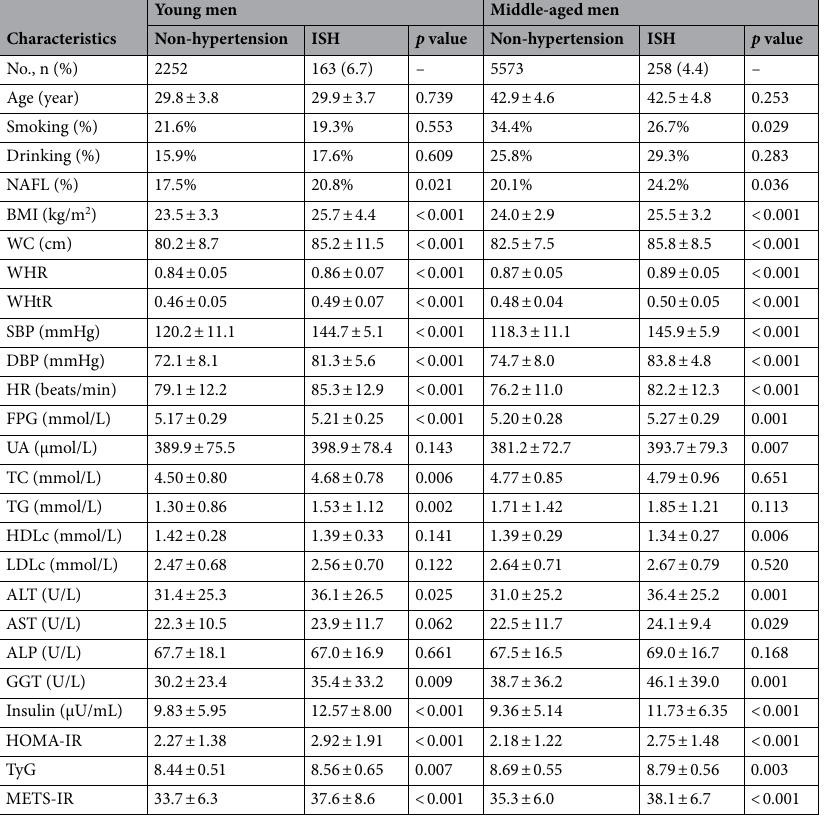
Table 1. The basic clinical characteristics of young and middle-aged men with normal fasting glucose by blood pressure status. NAFL nonalcoholic fatty liver, BMI body mass index, WC waist circumference, WHR waist to hip ratio, WHtR waist to height ratio, SBP systolic blood pressure, DBP diastolic blood pressure, HR heart rate, FPG fasting plasma glucose, UA plasma uric acid, TC total cholesterol, TG triglyceride, HDLc high-density lipoprotein cholesterol, LDLc low-density lipoprotein cholesterol, ALT alanine aminotransferase, AST aspartate aminotransferase, ALP alkaline phosphatase, GGT gamma glutamyltranspeptidase, HOMA-IR homeostasis model assessment for IR index, TyG triglyceride glucose index, METS-IR metabolic score for